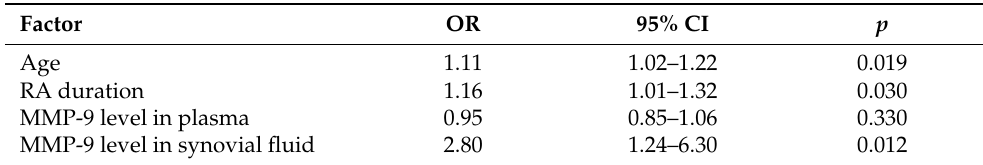
Table 3. Logistic regression model for the assessment of certain risk factors’ impact on the erosion development.